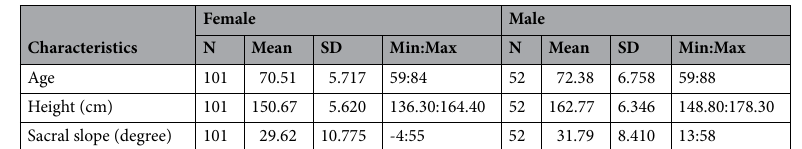
Table 1. Characteristics of the study population. SD standard